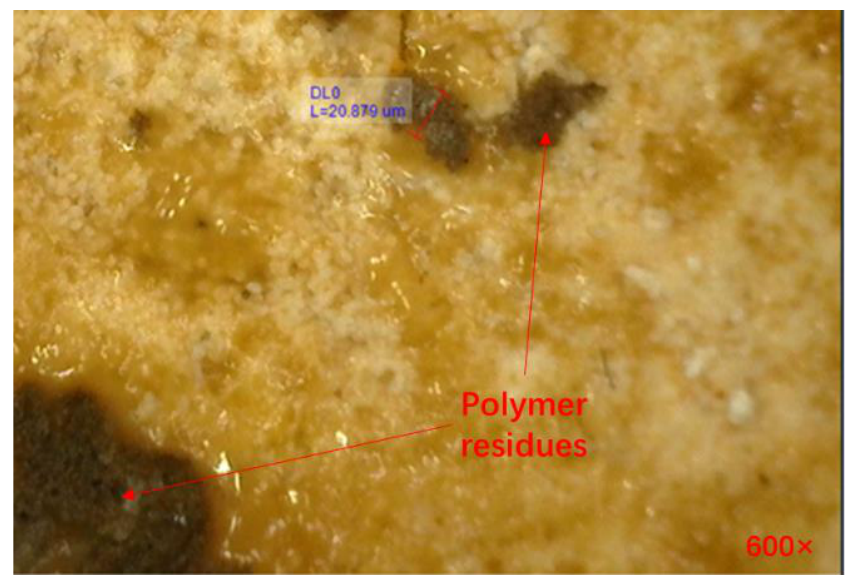
Figure 15. Core permeability in different treatment stages.